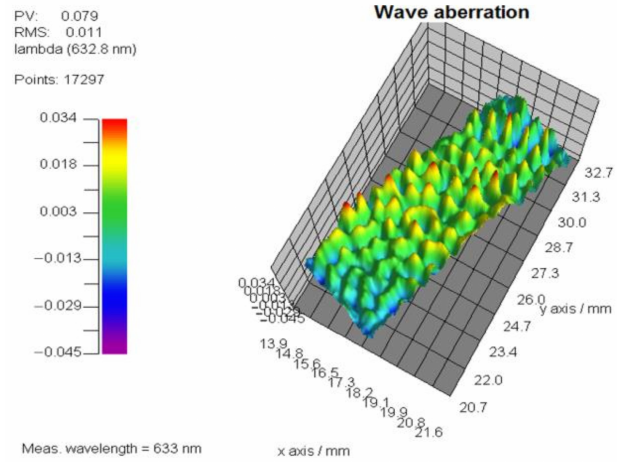
Figure 14. The iterative phase compensation